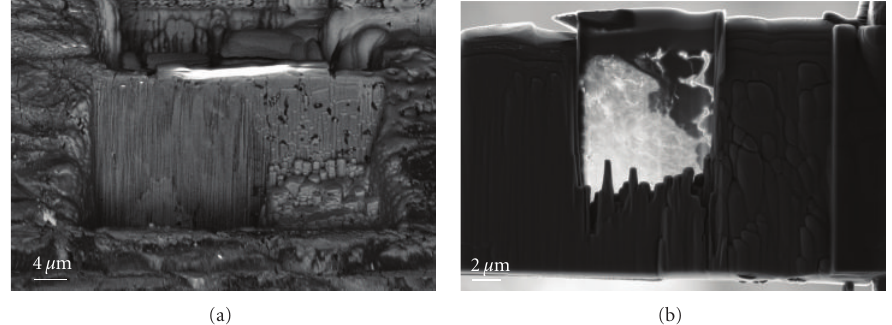
Figure 4: TEM sample preparation of a hydroxyapatite sca ff old (right portion of sample) interfacing to human bone (left portion of sample) by FIB. Pillars of remaining material due to di ff erential milling rates are seen in (a), while the final sample can be thinned to uniform thickness, (b), with continued